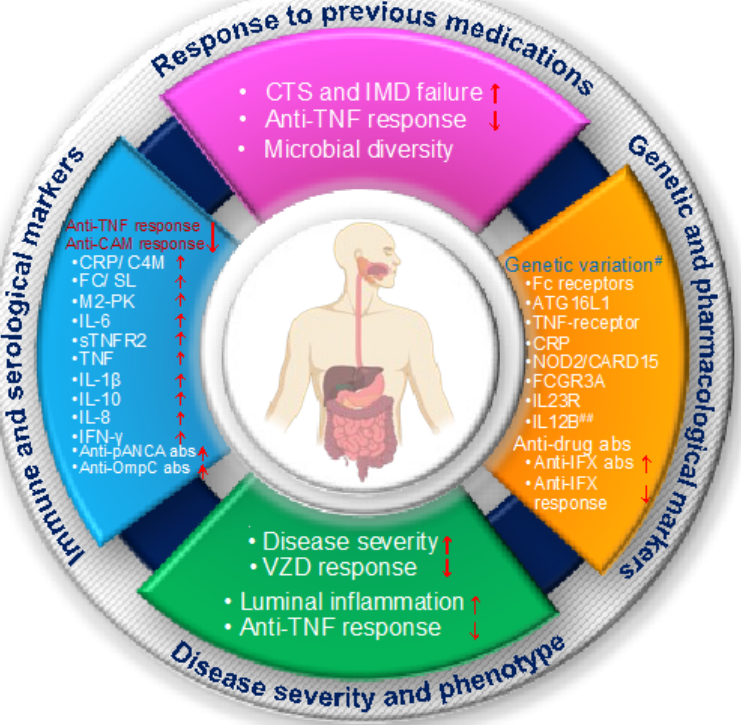
Figure 3. Predictive biomarkers for different IBD treatments. The figure shows the list of different pre- dictive biomarkers that are associated with disease severity and response to clinical therapy in patients with IBD. # Genetic variations in these genetic markers could predict a non-responsiveness to anti-TNF (infliximab) therapy in IBD patients. ## Heterozygous genotype of IL12B—10993 G > C (rs3212217) positively correlated with non-responsiveness to anti-TNF therapy in UC patients. CRP: C-reactive protein; FC: fecal calprotectin; SL: stool lactoferrin; CTS: corticosteroids; IMD: immunomodulators; IFX: infliximab; VZD: vedolizumab; TNF: tumor necrosis factor; C4M: Matrix metalloproteinases- mediated degradation of type IV collagens; IL: interleukin; sTNFR2: Serum soluble tumor necrosis factor receptor-2; IFN: Interferon; FCGR3A: Fc Gamma Receptor 3a; abs: antibodies; pANCA abs: perinuclear antineutrophil cytoplasmic antibodies; Anti-OmpC abs: anti- outer-membrane protein OmpC of Escherichia coli antibodies; Fc: fragment crystallizable; NOD: nucleotide-binding and oligomerization domain; CARD 15: caspase recruitment domain-containing protein 15; ↑ : increase in levels; ↓ : decrease in